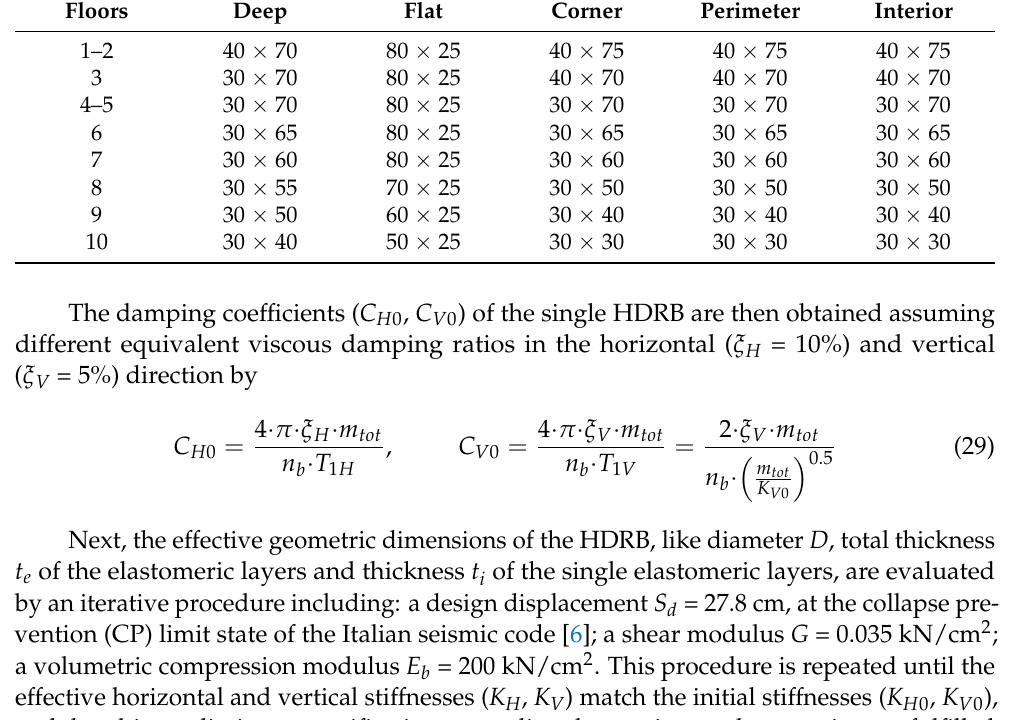
Table 5. Cross sections of beams and columns of the B10 structure (dimensions in cm). Beams